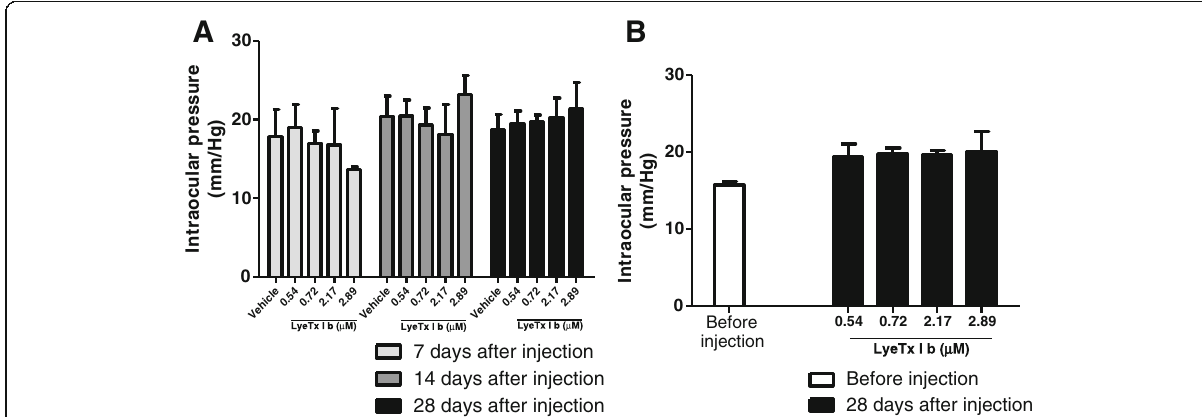
Fig. 3 LyeTx I b intravitreal injection does not interfere with intraocular pressure: a Graph shows the safety of intravitreal injection of LyeTx I b (0.36, 0.54, 0.72 or 2.89 μ M) 28 days after injection indicating no alterations compared to control group (Before injection). b Graph shows the safety of intravitreal injection of LyeTx I b (0.36, 0.54, 0.72 or 2.89 μ M) 7, 14 and 28 days after injection indicating no alterations compared to vehicle. Data represent the means ± SEM of three independent experiments. The abbreviation n.s. indicates no significant difference as compared to before injection or vehicle groups ( p >0.05). Abbreviations: SEM, standard error of the